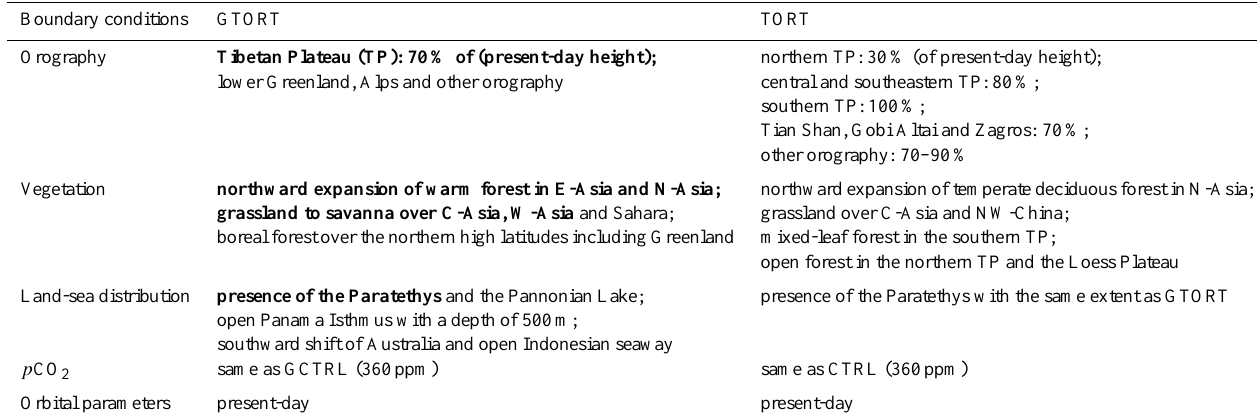
Table 1. The setup of the Tortonian physical boundary conditions in the global model (GTORT) and the regional model (TORT). For GTORT, the boundary configurations within the regional model domain are in